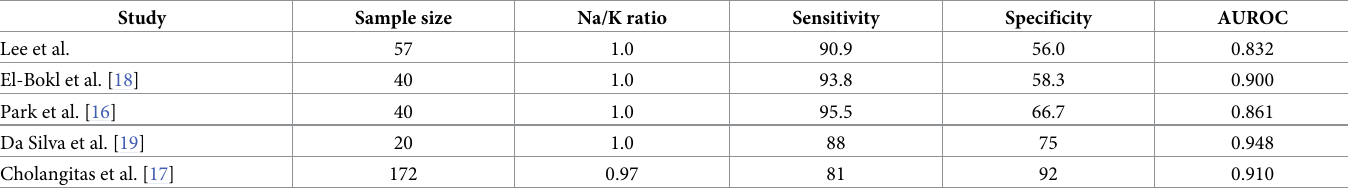
Table 4. Sensitivity, specificity, and AUROC of spot urine Na/K ratio in predicting 24-h urine Na excretion of previous studies’